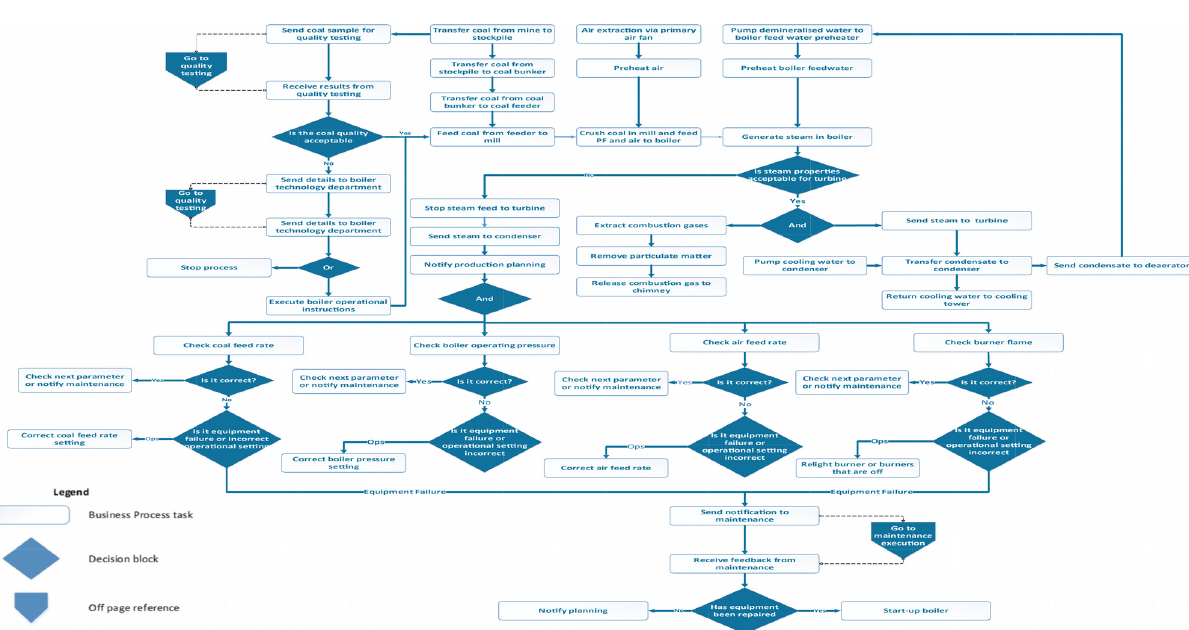
Figure A1: Steam generation business